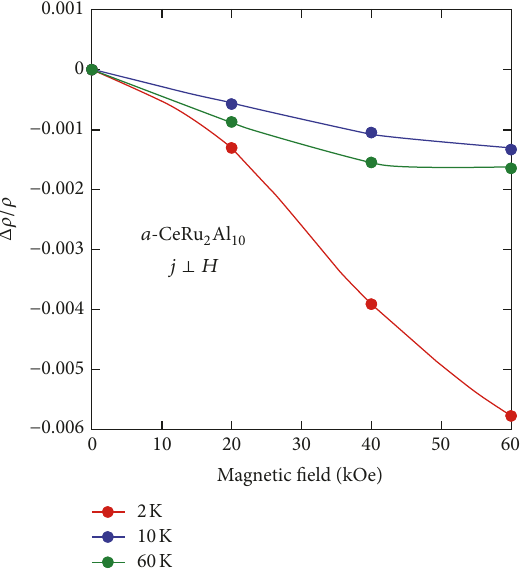
Figure 5: Field dependence of the magnetoresistance Δ𝜌/𝜌 at various temperatures for a -CeRu 2 Al 10 alloy.